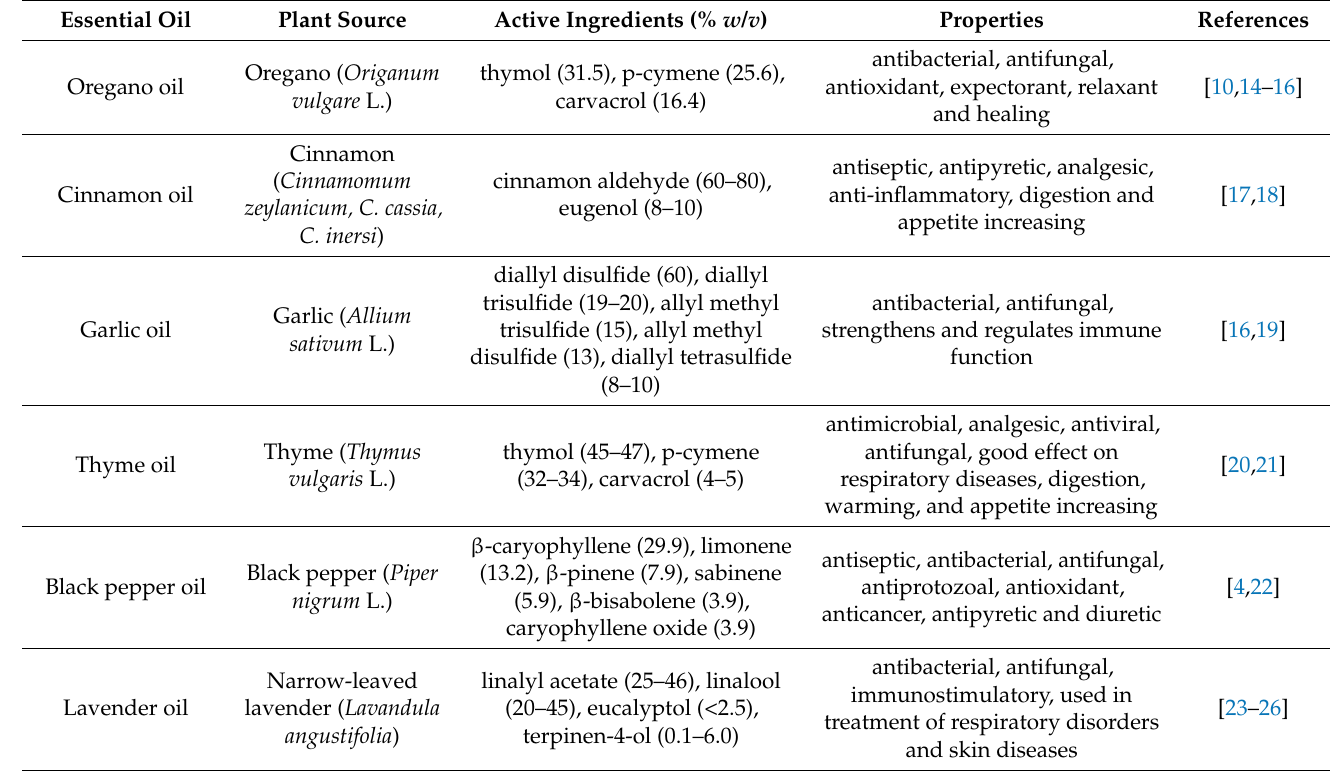
Table 1. Origin, chemical composition and properties of selected essential